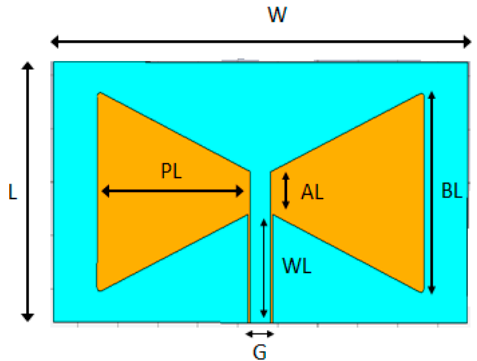
Figure 1. The design geometry of antenna A and B with same RT / Duroid 5880 materials substrate and di ff erent substrate thickness. Table 1. Antenna A parameters.